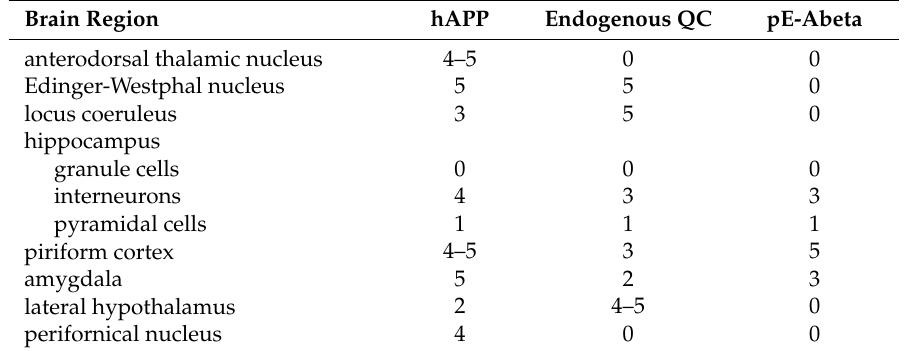
Table 1. Spatial expression of hAPP and endogenous QC and deposition of pE-Abeta in Tg2576 brain. Brain Region hAPP Endogenous